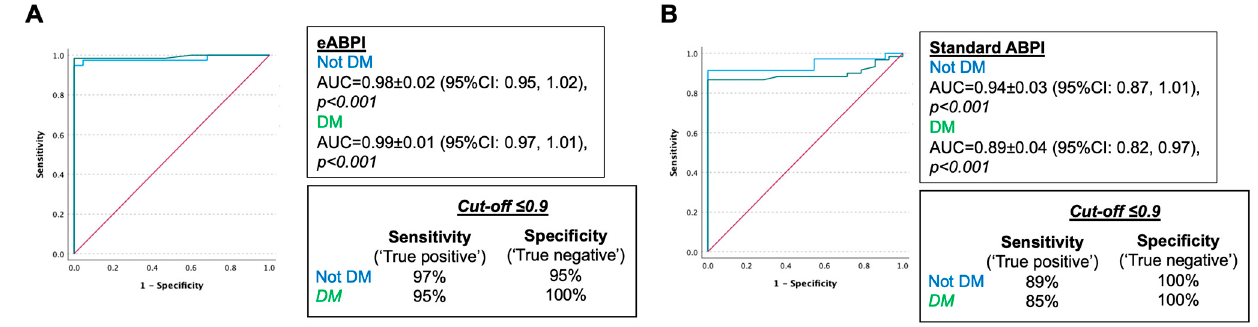
Figure 6. ROC analysis to test the performance of ( A ) eABPI and ( B ) standard ABPI to detect PAD (diagnosed as > 50% stenosis on Duplex ultrasound) in legs of patients without and with diabetes mellitus (DM). ( A ) total n = 139 legs, n = 78 DM, p = 0.608, ( B ) total = 120 legs, n = 74 DM, p = 0.349 .